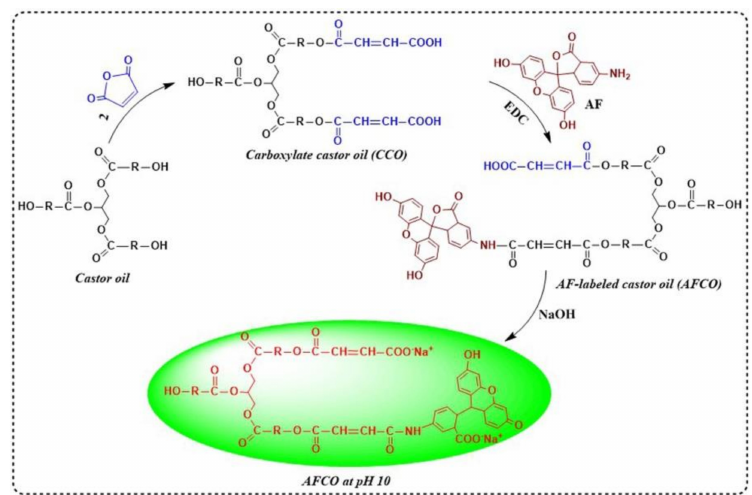
Figure 1. Synthesis procedures of fluorescently labeled tracer